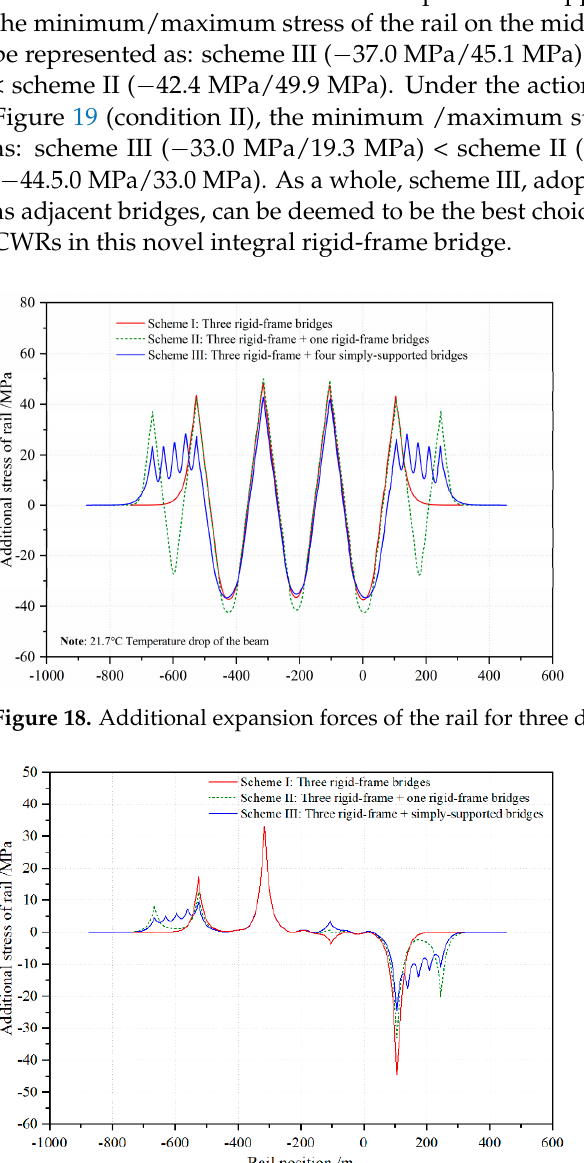
Figure 17. Three calculation models of the adjacent bridges with different arrangement schemes.